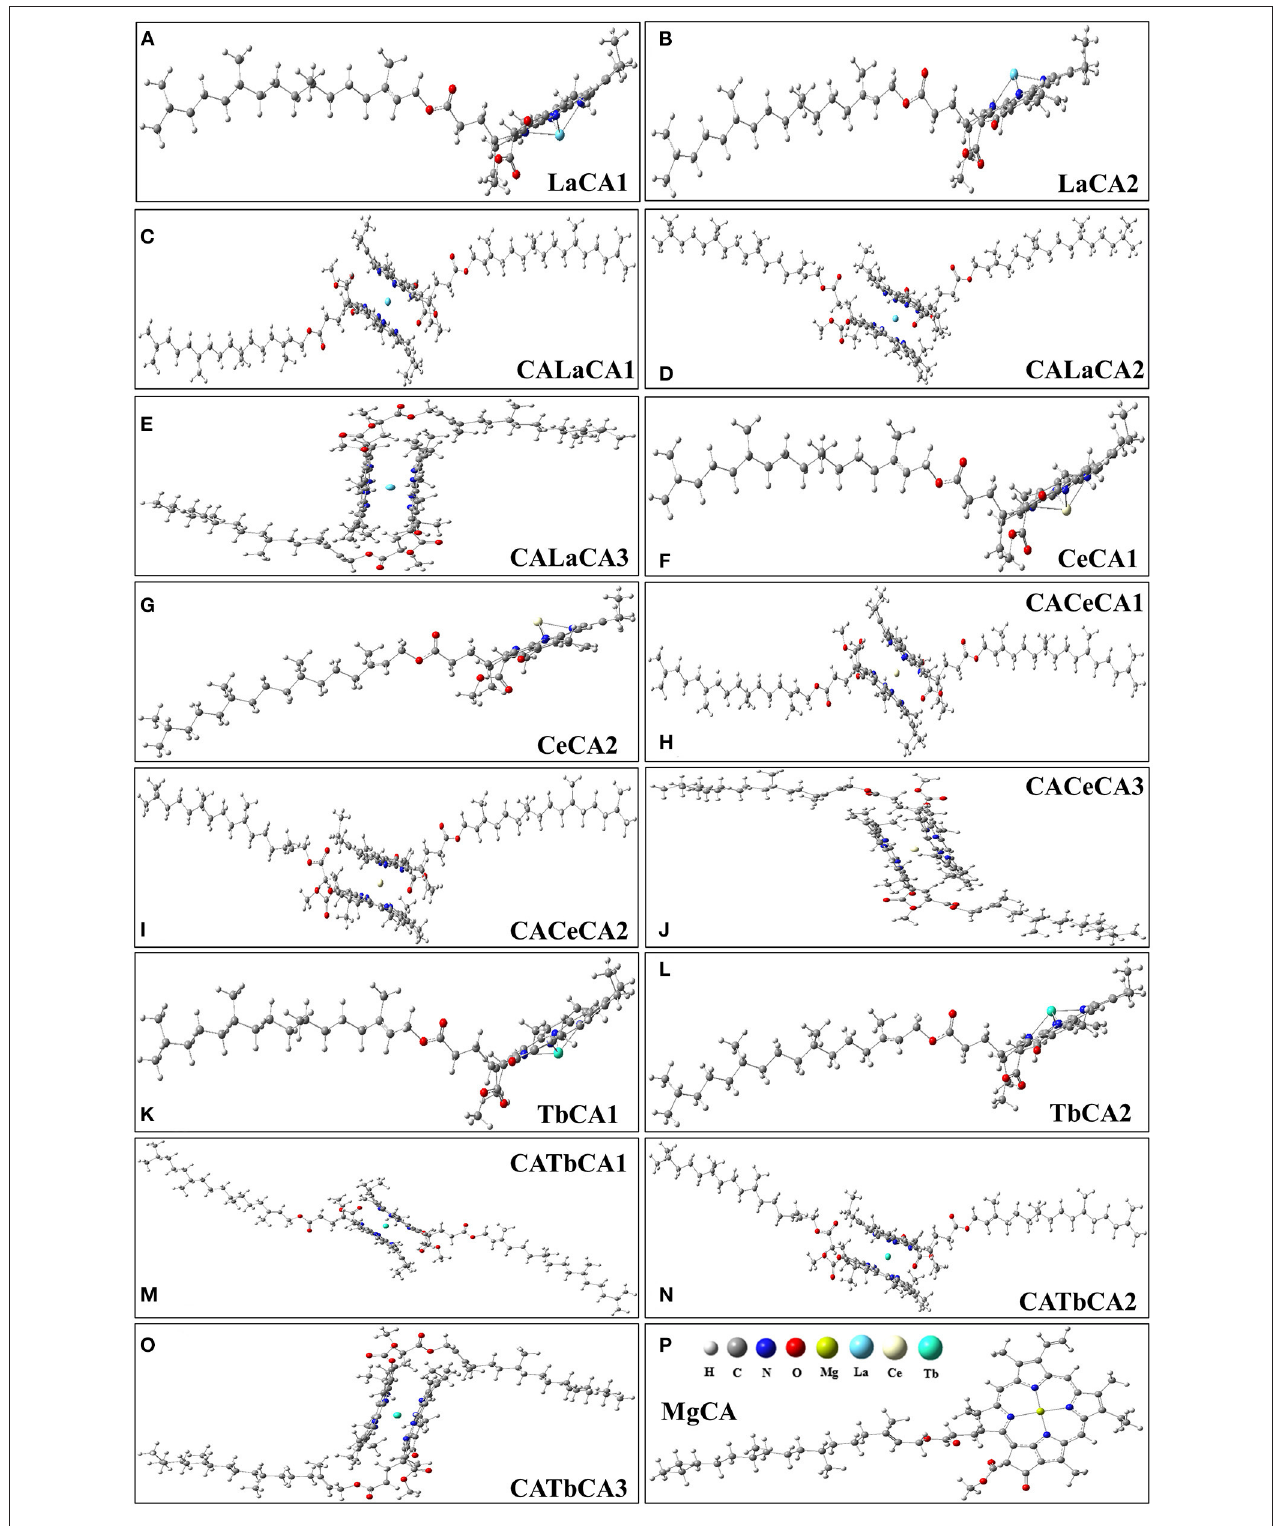
FIGURE 4 | Optimized structures of products for the reactions between La, Ce, Tb, and chlorophyll a. (A,B) lanthanum mono-chlorophyll a, (C–E) lanthanum bis-chlorophyll a, (F,G) cerium mono-chlorophyll a, (H–J) cerium bis-chlorophyll a, (K,L) terbium mono-chlorophyll a, (M–O) terbium bis-chlorophyll a, (P) chlorophyll a.